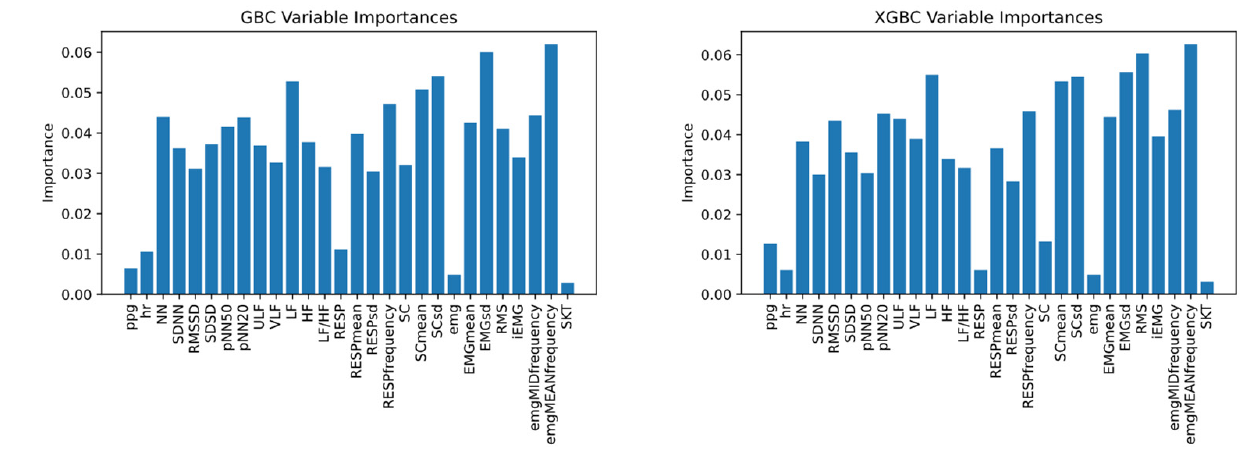
Figure 8. The importance ranking of the four different classifiers.